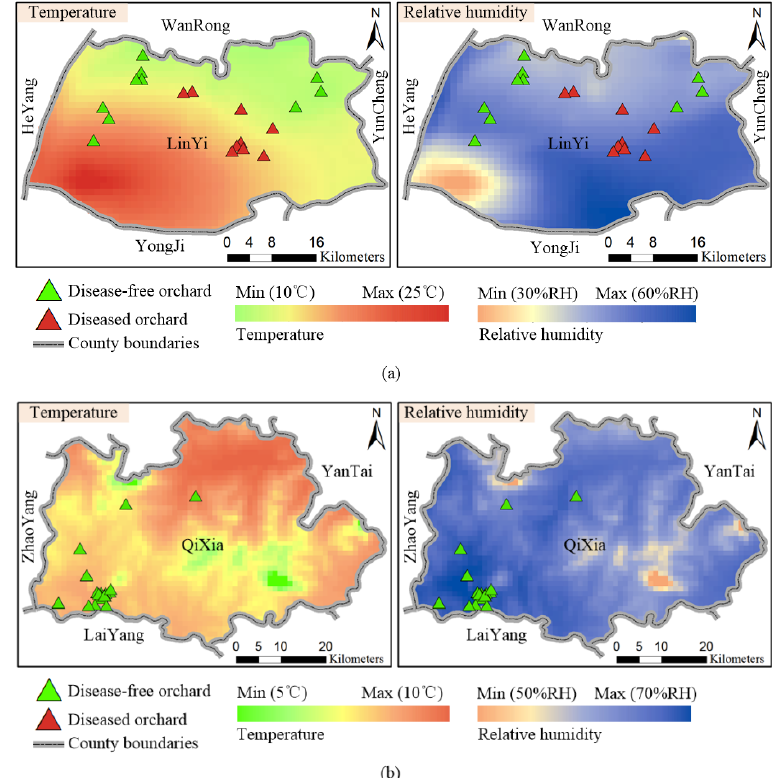
Figure 2. A demonstration of spatial distribution of temperature (spatial resolution: 1 km) and relative humidity (spatial resolution: 1 km) within Linyi County ( a ); and Qixia County ( b ).